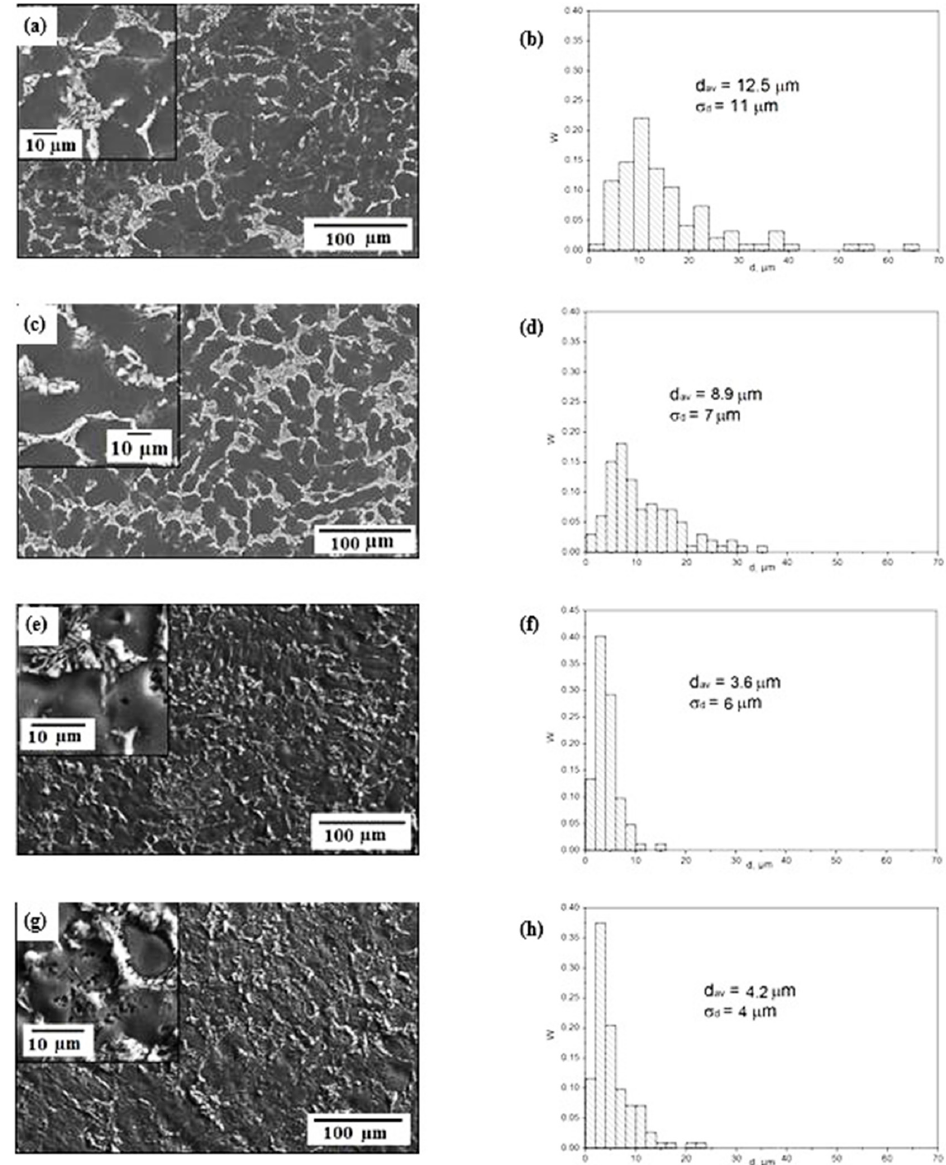
Figure 1. Morphology and a histogram of particles distribution by the sizes of eutectic Si: ( a , b ) in the initial alloy; ( c , d ) supplemented with 0.4 mass. % Ultrafine powders; ( e , f ) 0.2 mass. % K 2 ZrF 6 ; ( h , g ) 0.2 mass. % Arsal 2120.